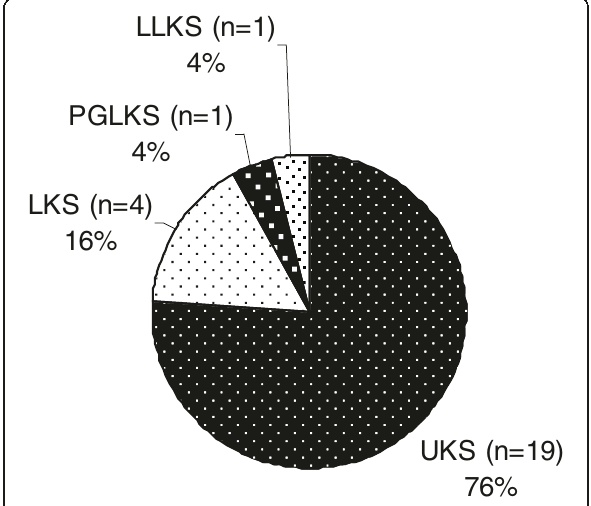
Figure 6 Histological component of Kaposi sarcoma cases showing vesiculobullous pattern (n=25). KS: Kaposi sarcoma, UKS: Usual KS), LKS: Lymphangiectatic KS, LLKS: Lymphangiom- like KS, PGLKS: Pyogenic granuloma-like